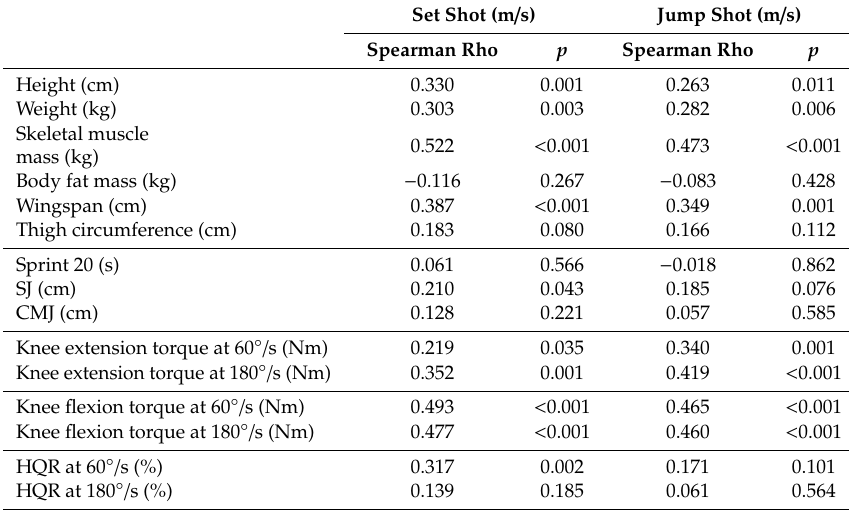
Table 4. Correlations between playing positions in sprinting, vertical jump performance, and handball shooting